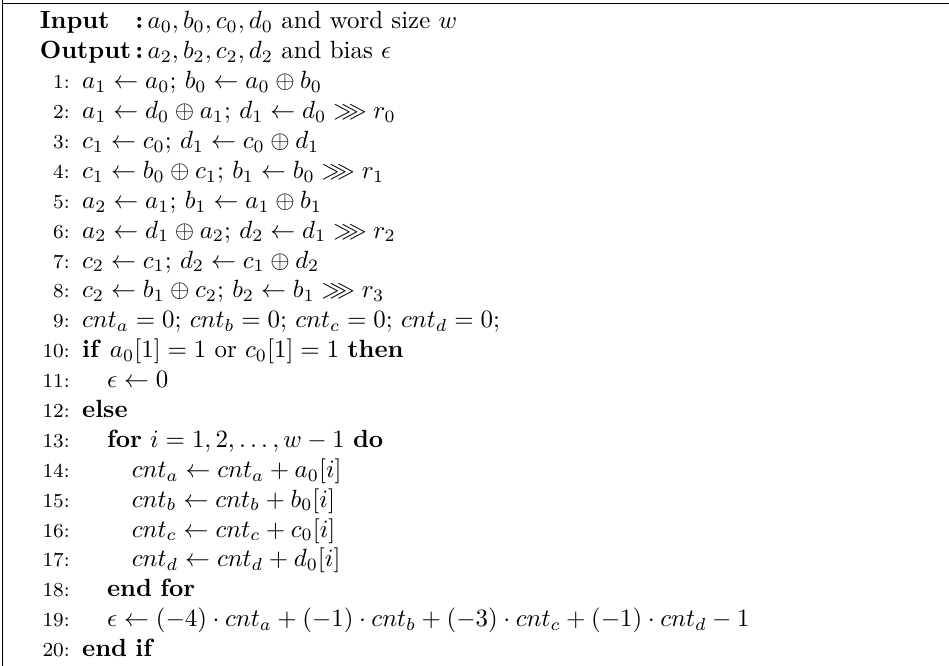
Algorithm 1: Linear approximation of G